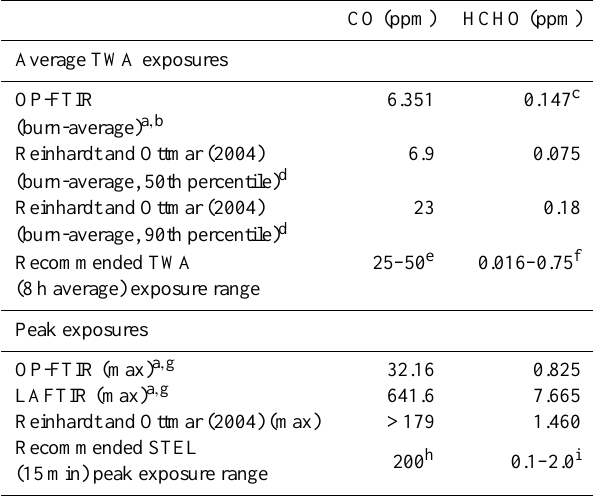
Table 3. Average TWA and peak exposures measured in this work and other studies and recommended TWA and peak